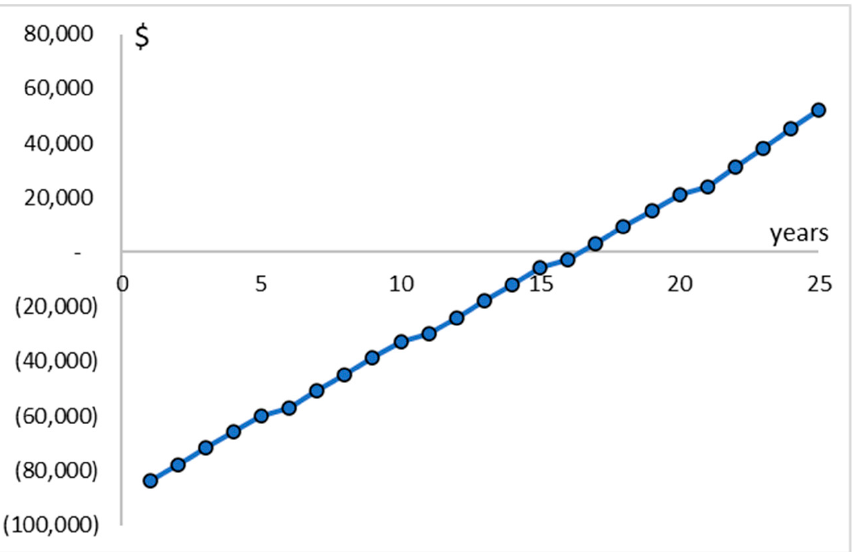
Figure 9. The study’s financial development for the facility. Table 9. Values used for economic evaluation. PVSB distance from the